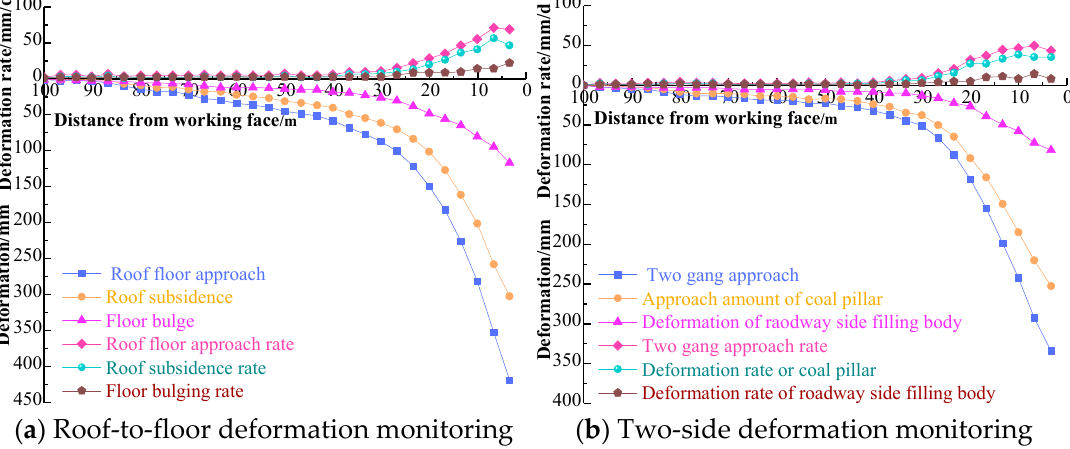
Figure 22. Monitoring of surrounding-rock deformations of gob-side entry-retaining technology.